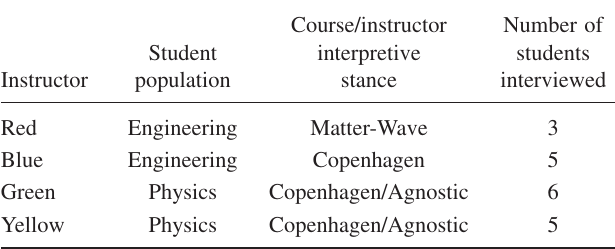
TABLE I. Summary of the four courses from which students were recruited for interviews, including a characterization of each instructor’s stance on interpretive themes as taught in that course. A total of 19 students were